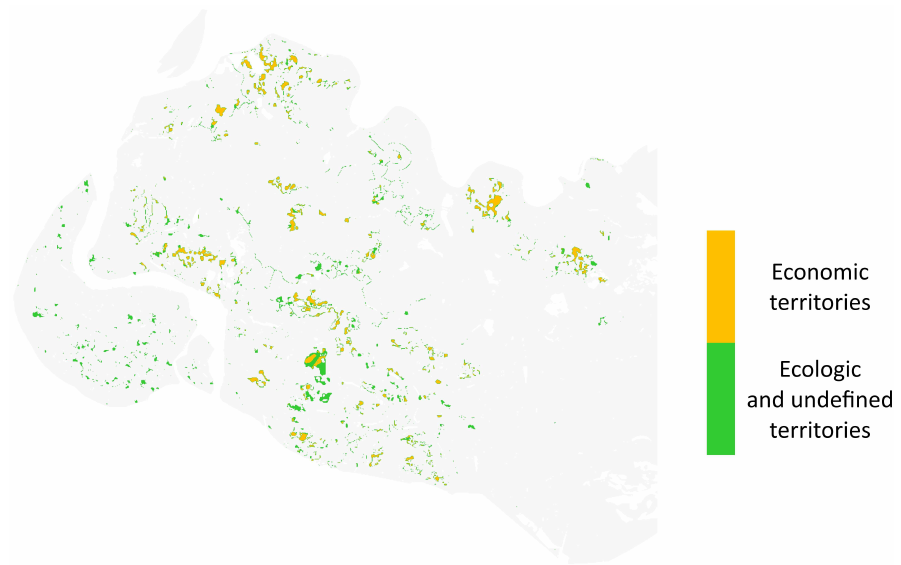
Figure 21. The area that will lose its flooding stability in the period 2022–2050 according to our